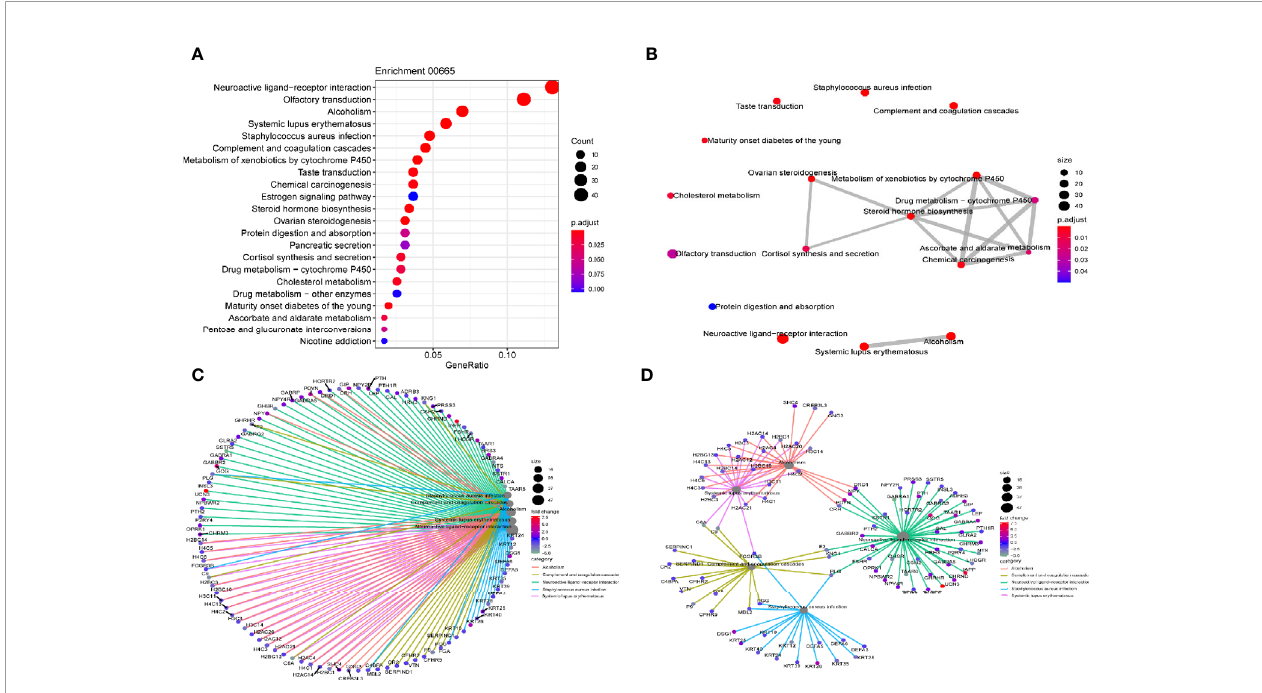
FIGURE 6 | KEGG pathway analysis (A) Dot plot re fl ects most enriched pathways; (B) Map plot re fl ects relationship between enriched pathways; (C, D) Net plot indicates DEG (differential expressed gene) distribution in different enriched